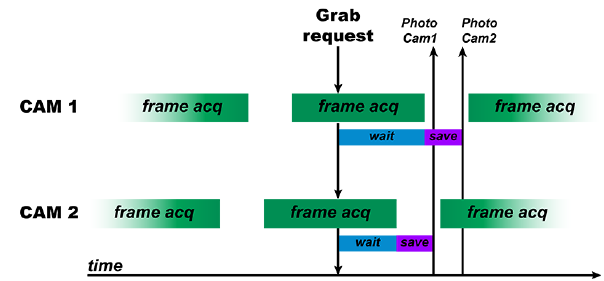
Figure 3. Process capture via the Raspicam library: grab is requested simultaneously during the capture process and is actually carried out for each sensor when it has just finished acquiring a frame, hence a certain delay between the two recovered acquisitions.